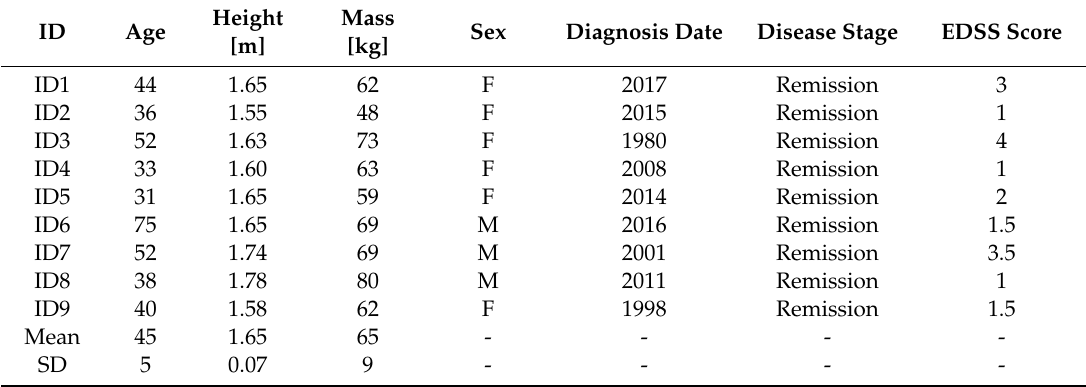
Table 1. Demographic details of enrolled patients © 2019